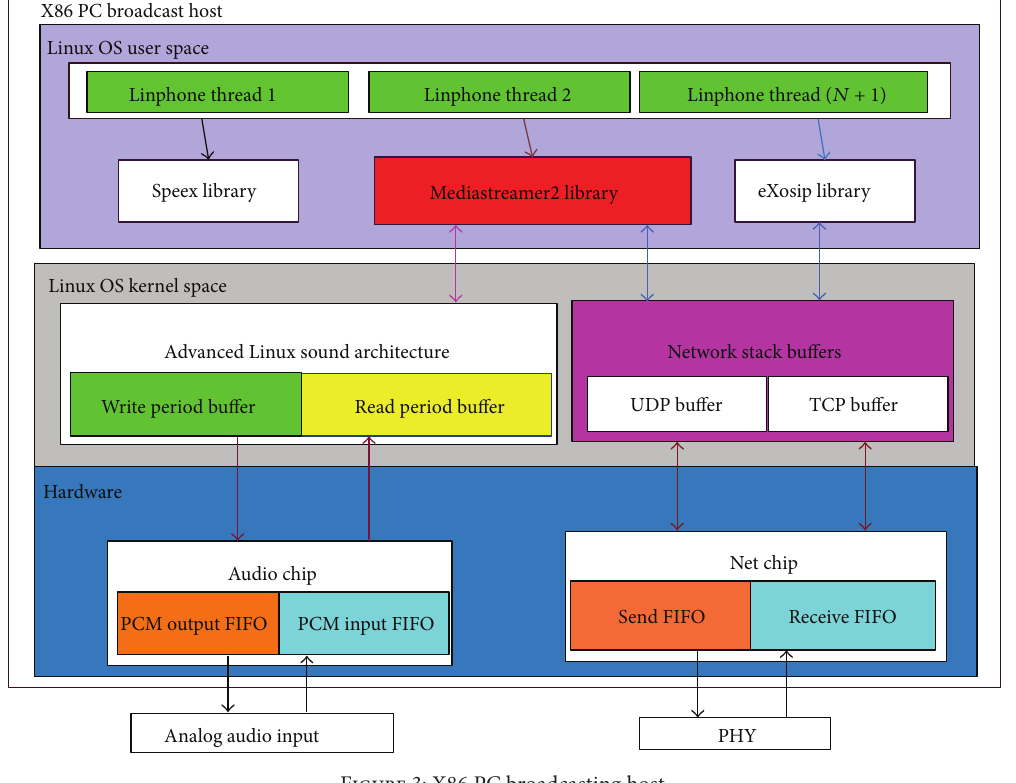
Figure 3: X86 PC broadcasting host.